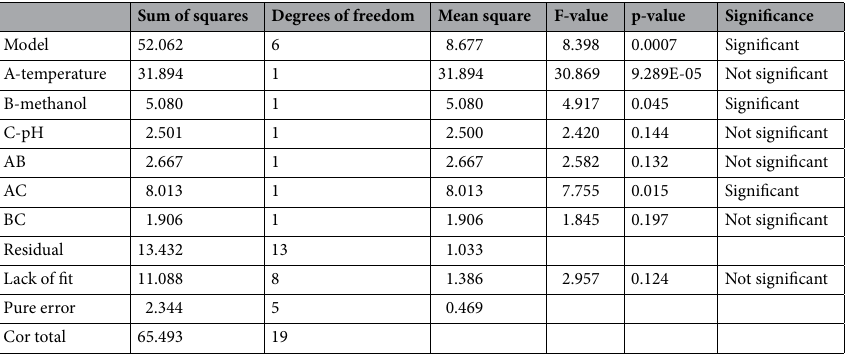
Table 5. ANOVA analysis of the obtained results of lipase catalytic activities.